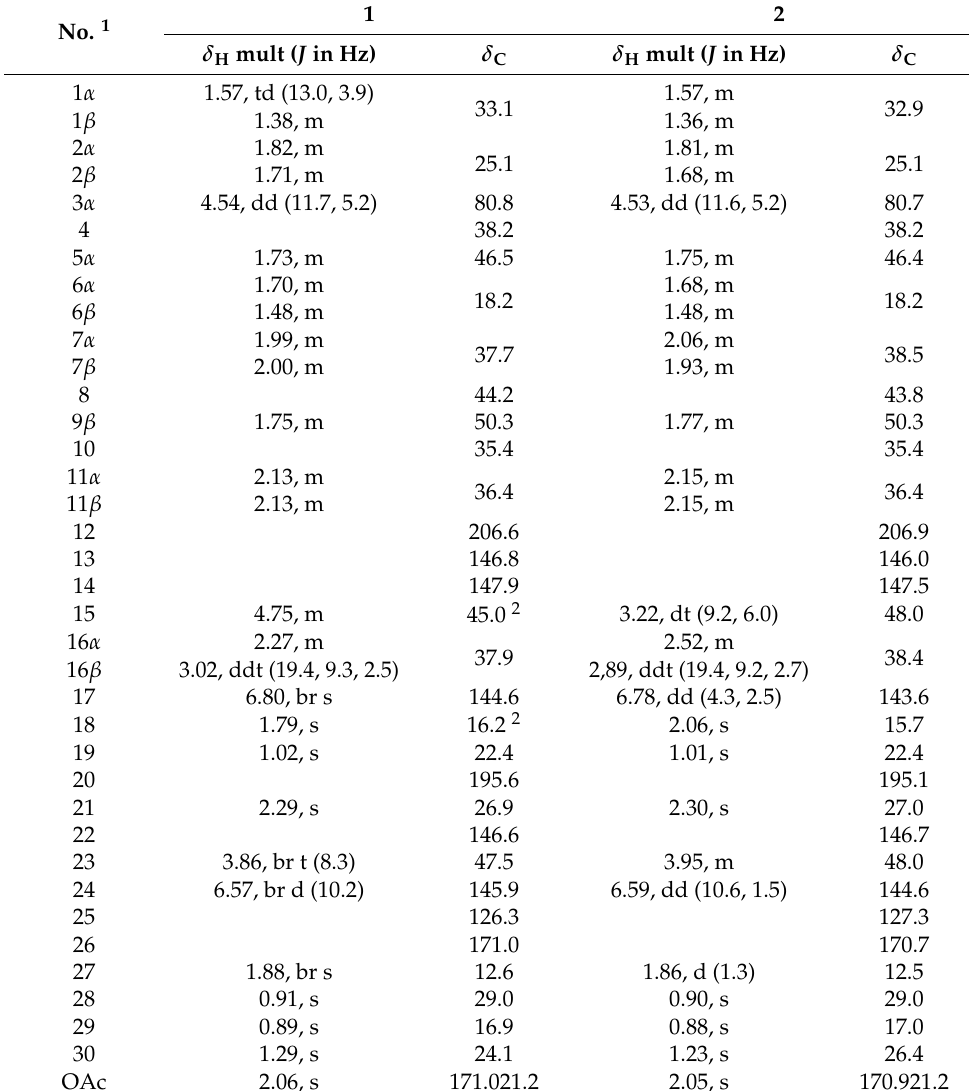
Table 1. 1 H and 13 C NMR data of 1 (700 and 176 MHz) and 2 (500 and 126 MHz) in CDCl 3